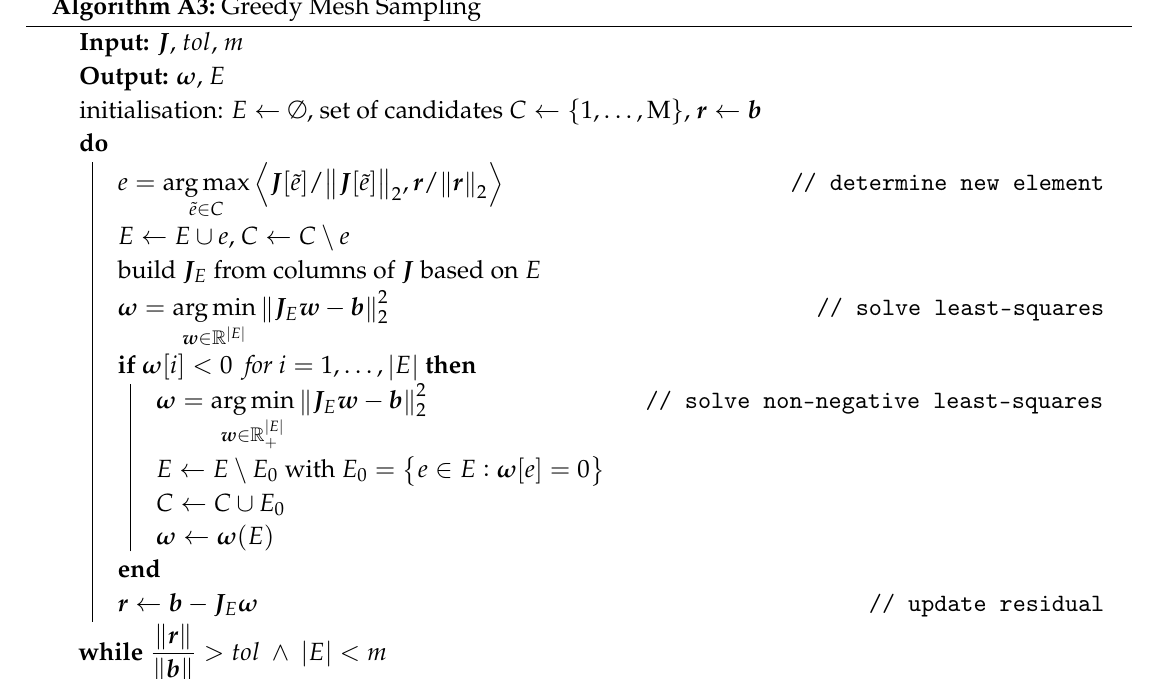
Algorithm A3: Greedy Mesh